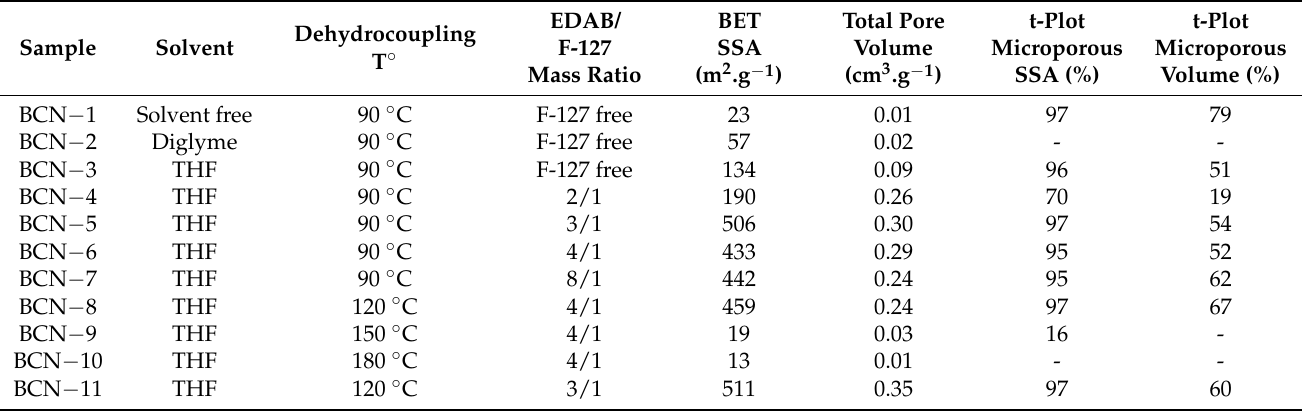
Table 1. The different synthesis conditions of BCN